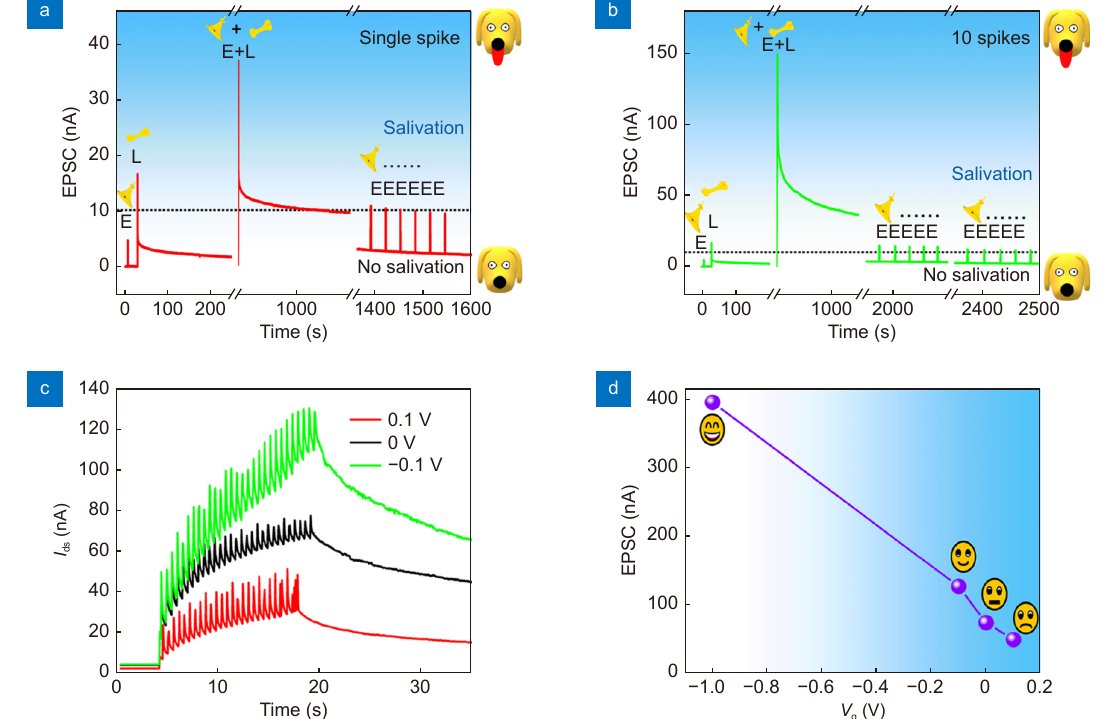
Fig. 5 | Schematic illustration of the Pavlovian conditioning and emotional effect on the MoS 2 synaptic transistor. The classical Pavlovi- an conditioning under one training (E+L) ( a ) and ten trainings ( b ). ( c ) The transient current triggered by 30 optical spikes at the backgate of 0.1 V, 0 V and –0.1 V. ( d ) The maximum EPSC at different V g